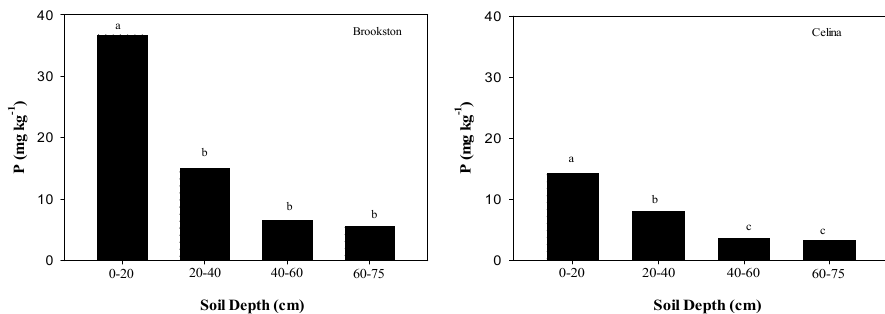
Figure 4. Phosphorous (P) concentration of Brookston and Celina soils in each soil layer. Means followed by the same letter or no letters for each soil and soil layer are not significantly different by Tukey’s test at p < 0.05 .